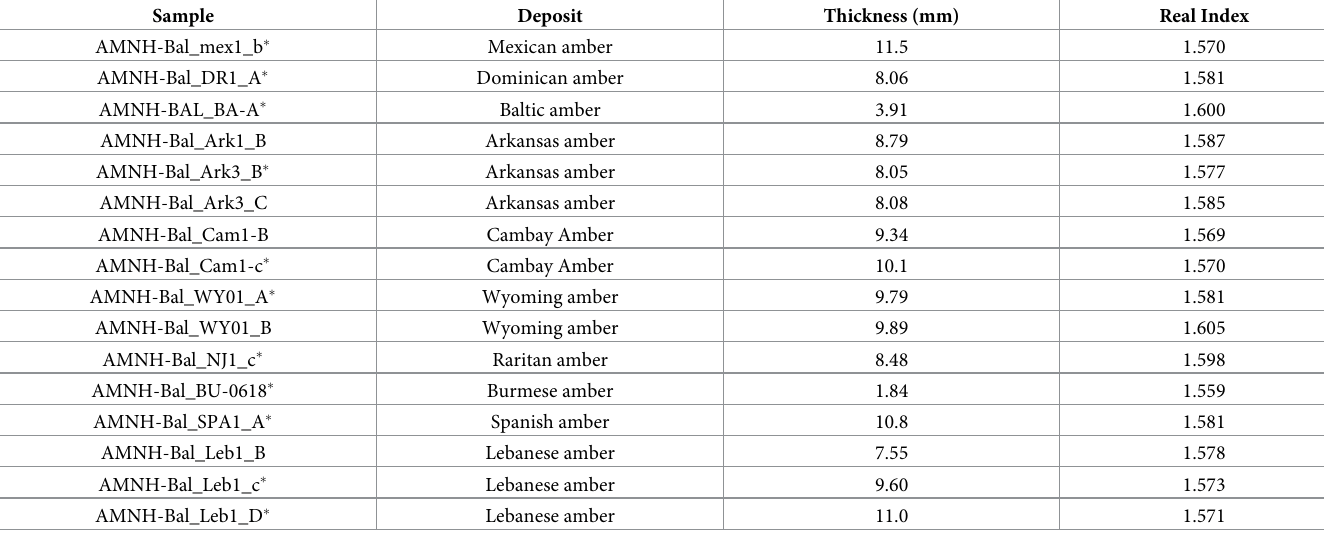
Table 2. Table of amber sample locality, thickness, and real refractive index values as measured by time-of-flight.